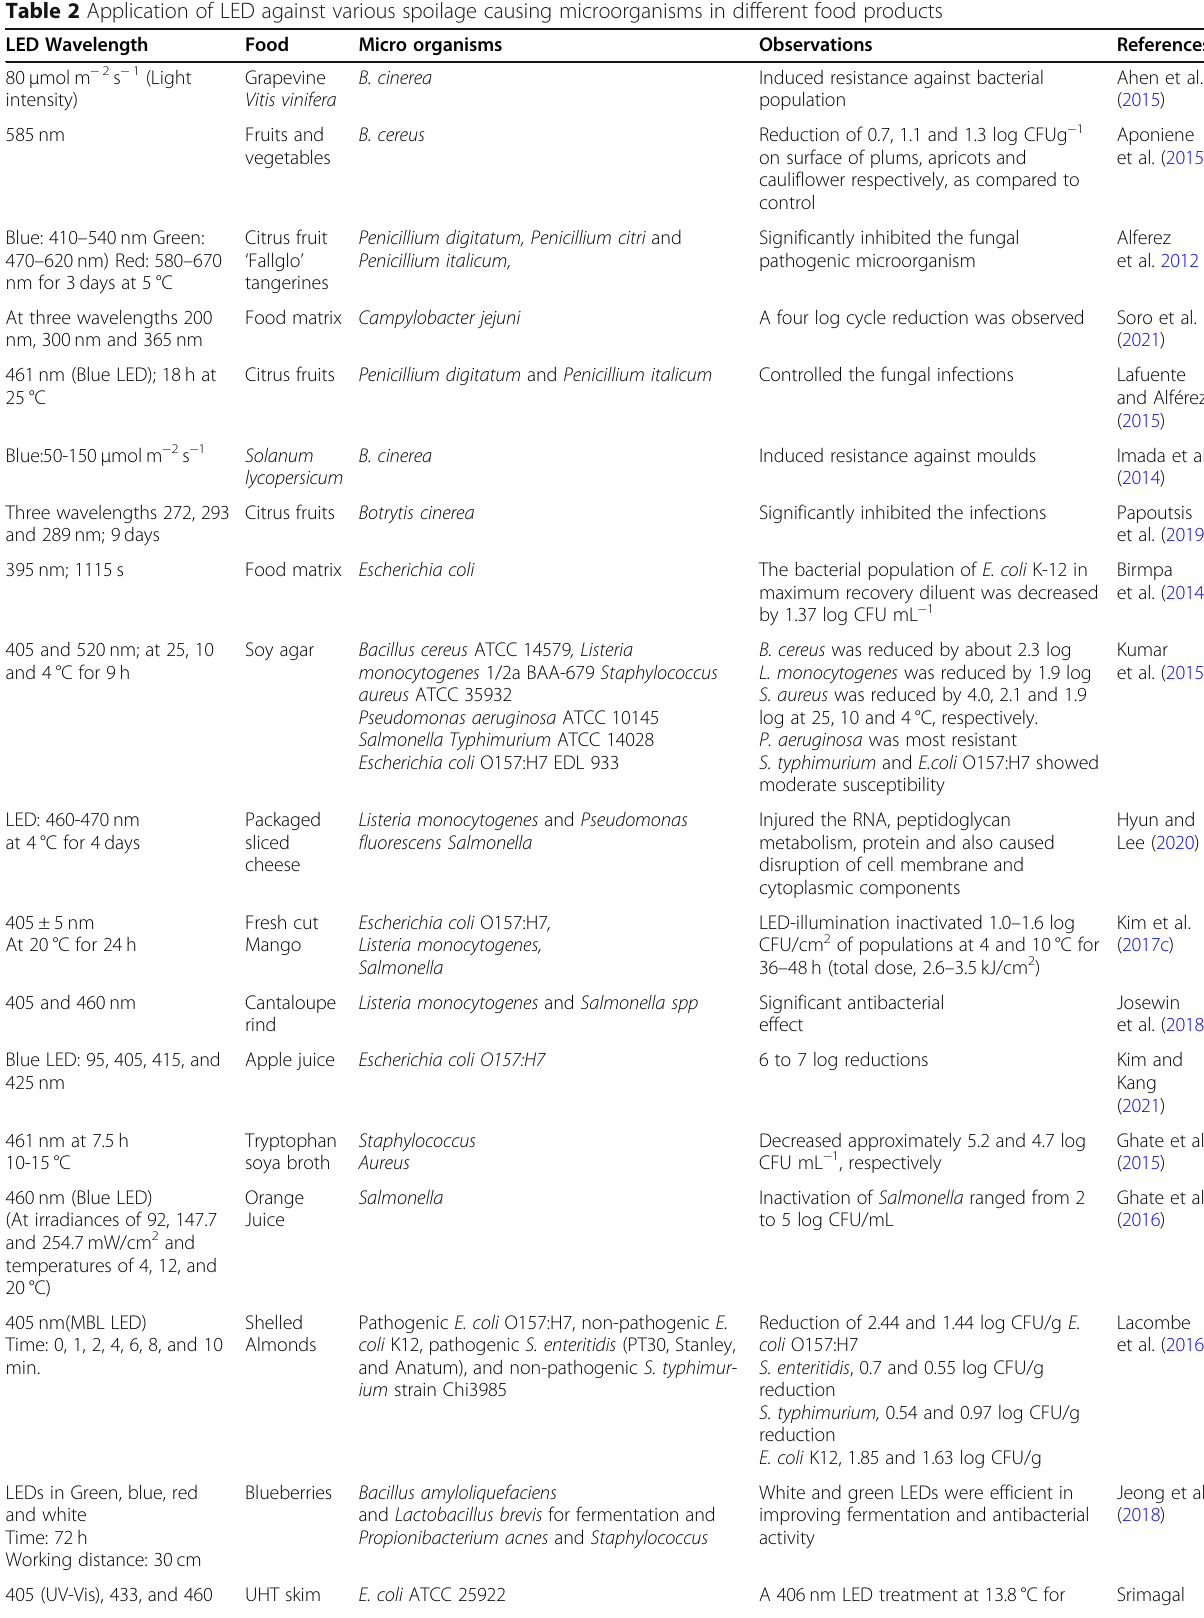
Table 2 Application of LED against various spoilage causing microorganisms in different food